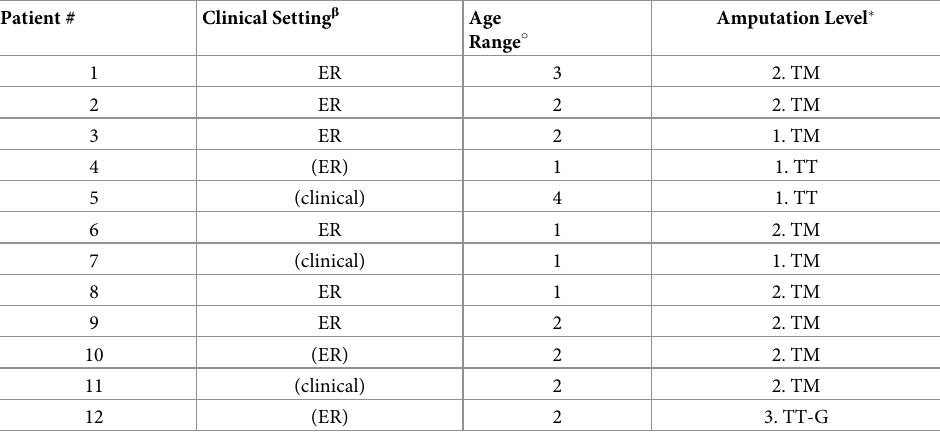
Table 2. Participant information for